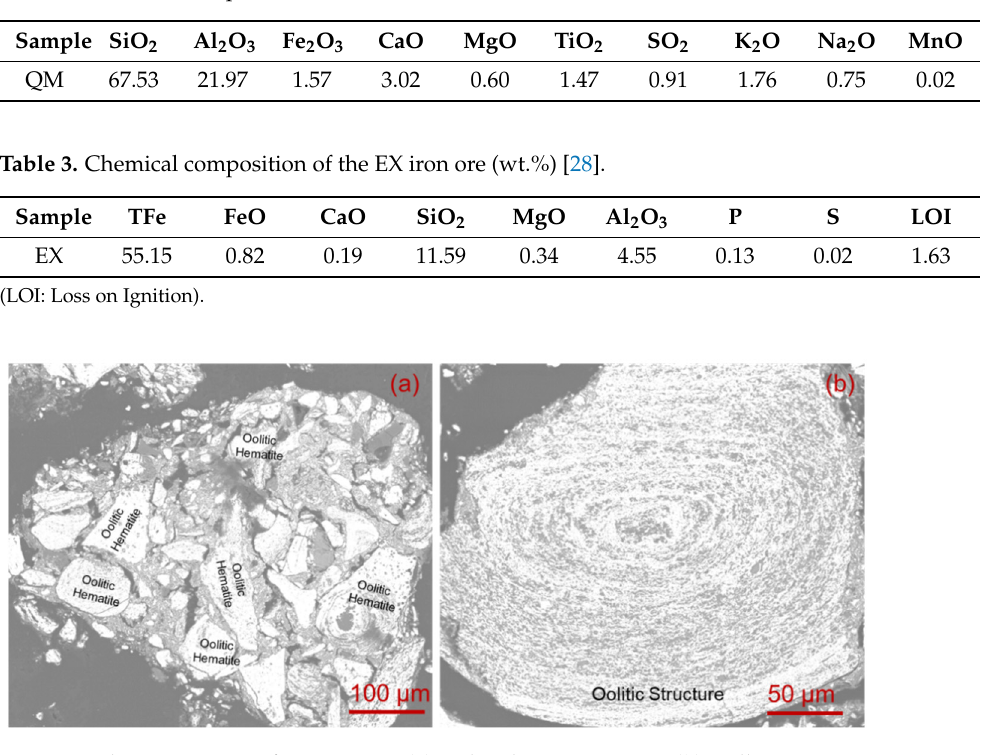
Figure 1. The SEM image of EX iron ore: ( a ) Oolitic hematite group; ( b ) Oollitic structure.